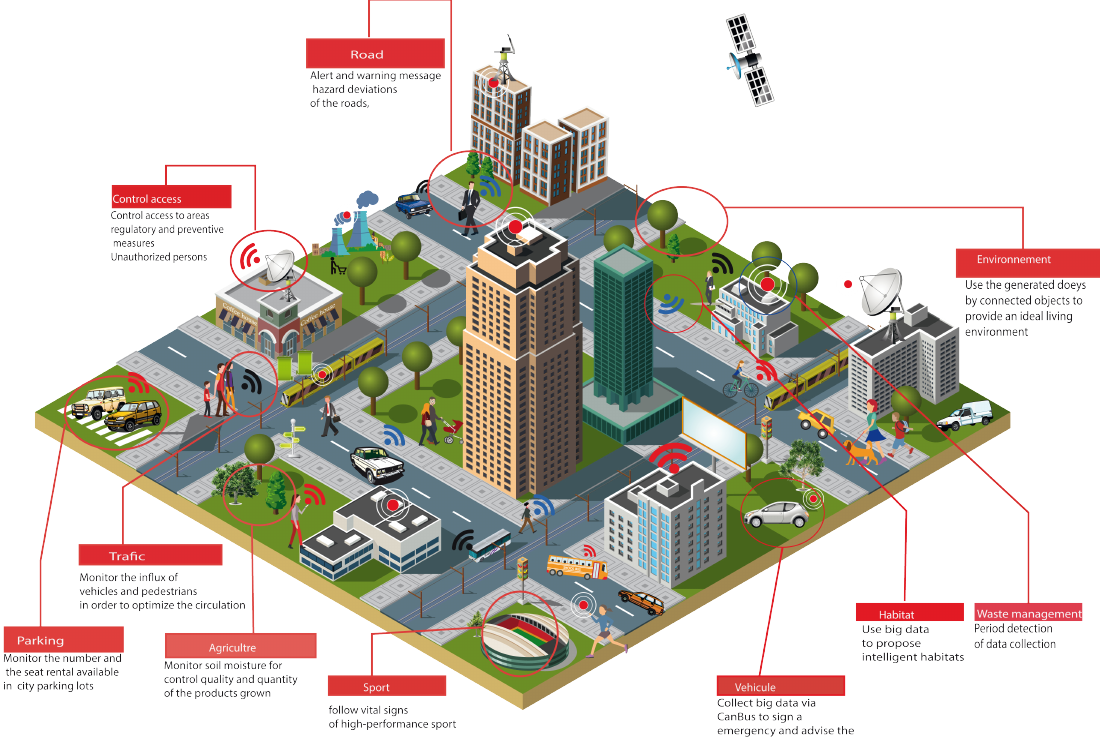
Figure 1. Field of services offered in a smart